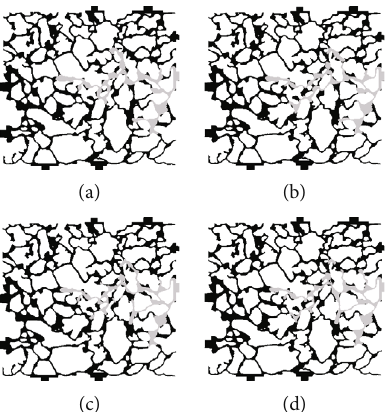
Figure 5: Oil distribution with same injection volume with di ff erent injection velocity under the oil-wet condition (contact angle θ = 165 ° ):